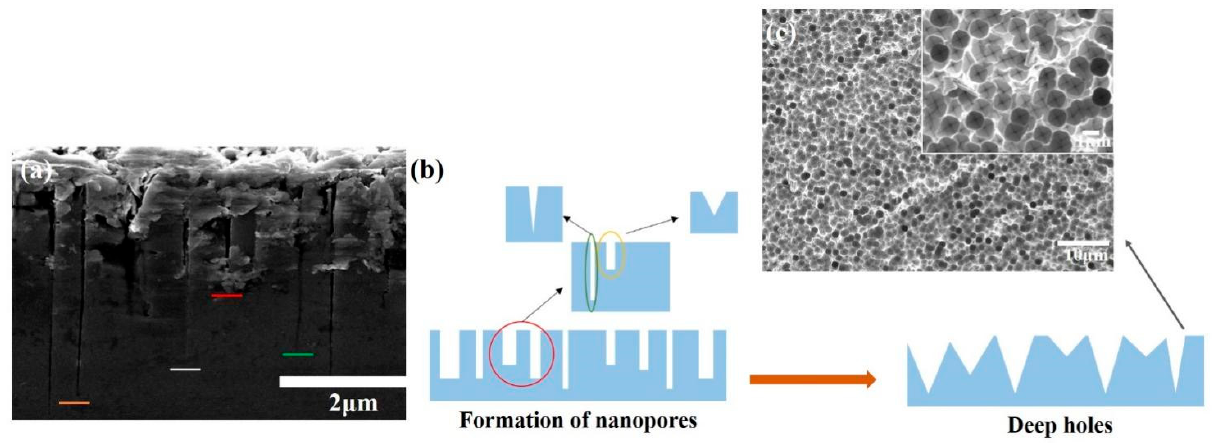
Figure 11. Cross-sectional SEM images of nanopores ( a ) and schematic diagram of nanopores treated by NSR process ( b , c ).